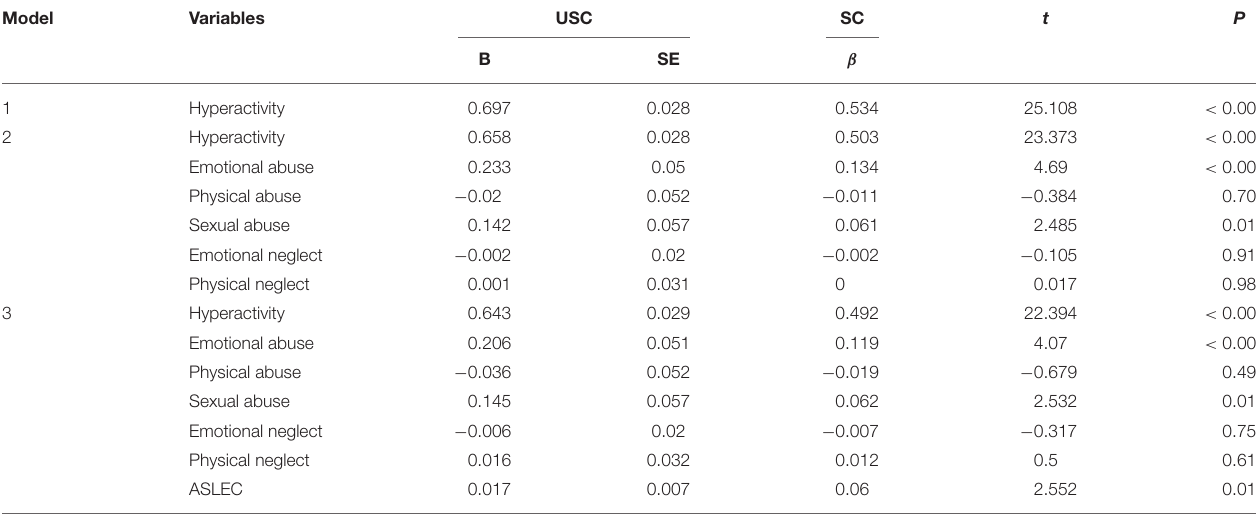
TABLE 3A | Linear regression analysis for hyperactivity, different types of childhood trauma, and life events predicting somatic complaints. Model